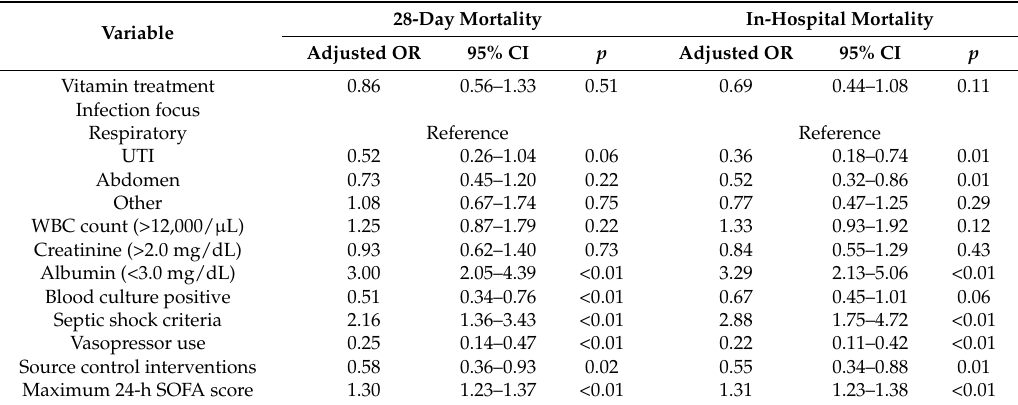
Table 3. Random-effects multivariate analysis of 28-day and in-hospital